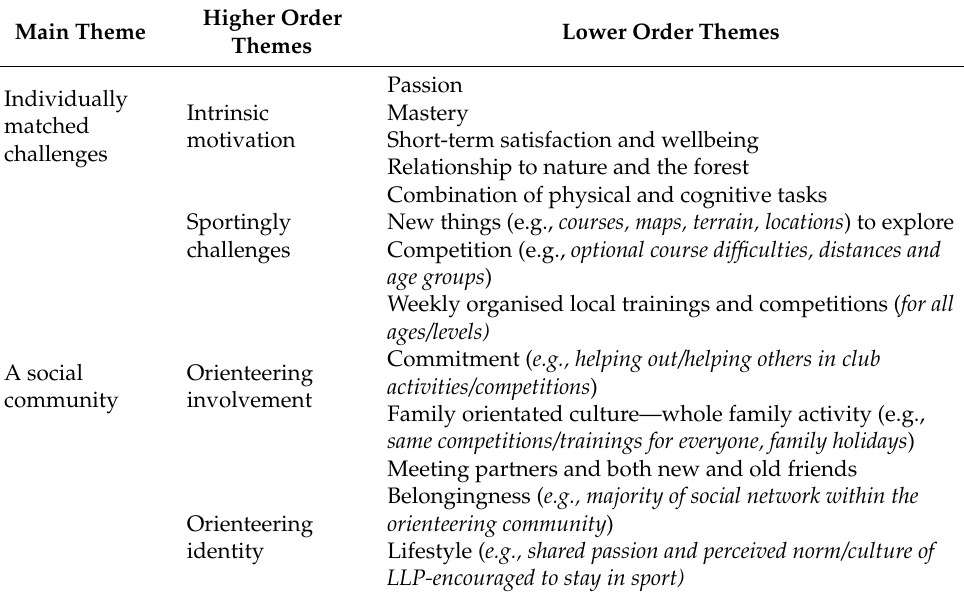
Table 2. Main themes in the thematic analysis of how orienteering is meaningful and rewarding for former elite athletes from a lifelong physical activity